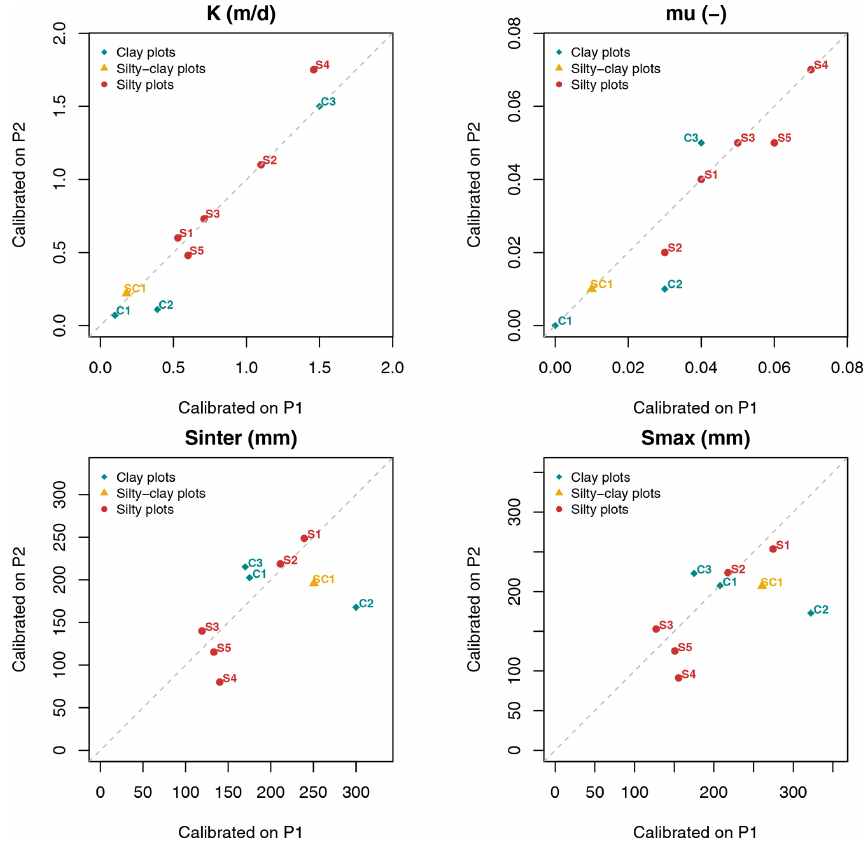
Figure 10. Comparison of parameter sets from both calibration periods (sites are referenced by their associated index, as shown in Table 1).